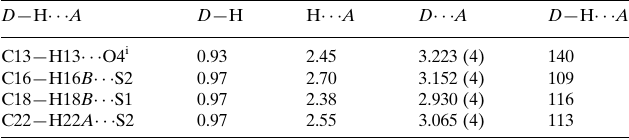
Hydrogen-bond geometry (A˚ , (cid:2)